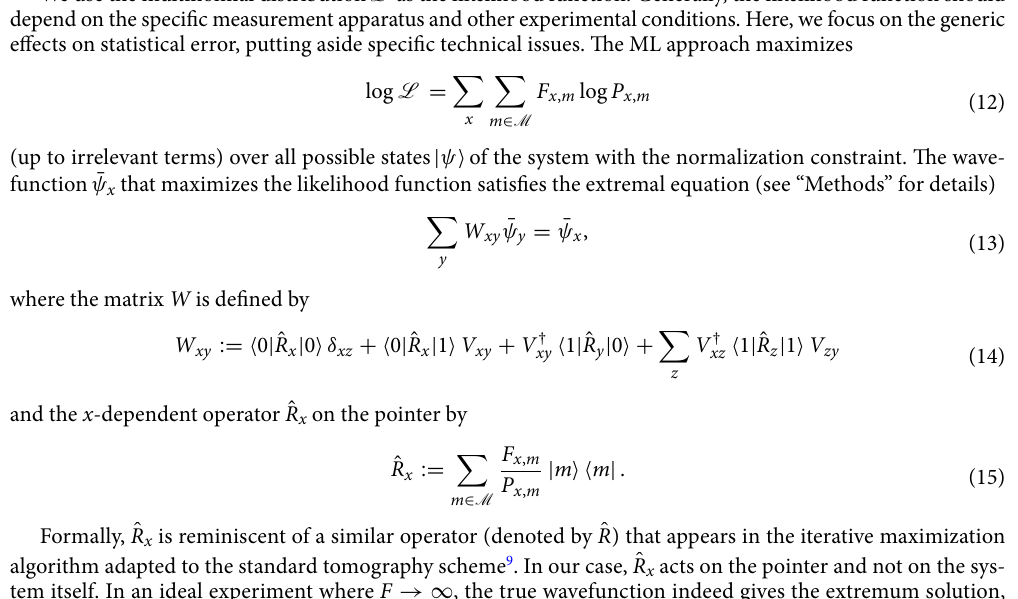
1 whereas the open circle indicates | � x of the system. Despite the quantum circuit | � ψ ( k ) depends on the trial state [ ]